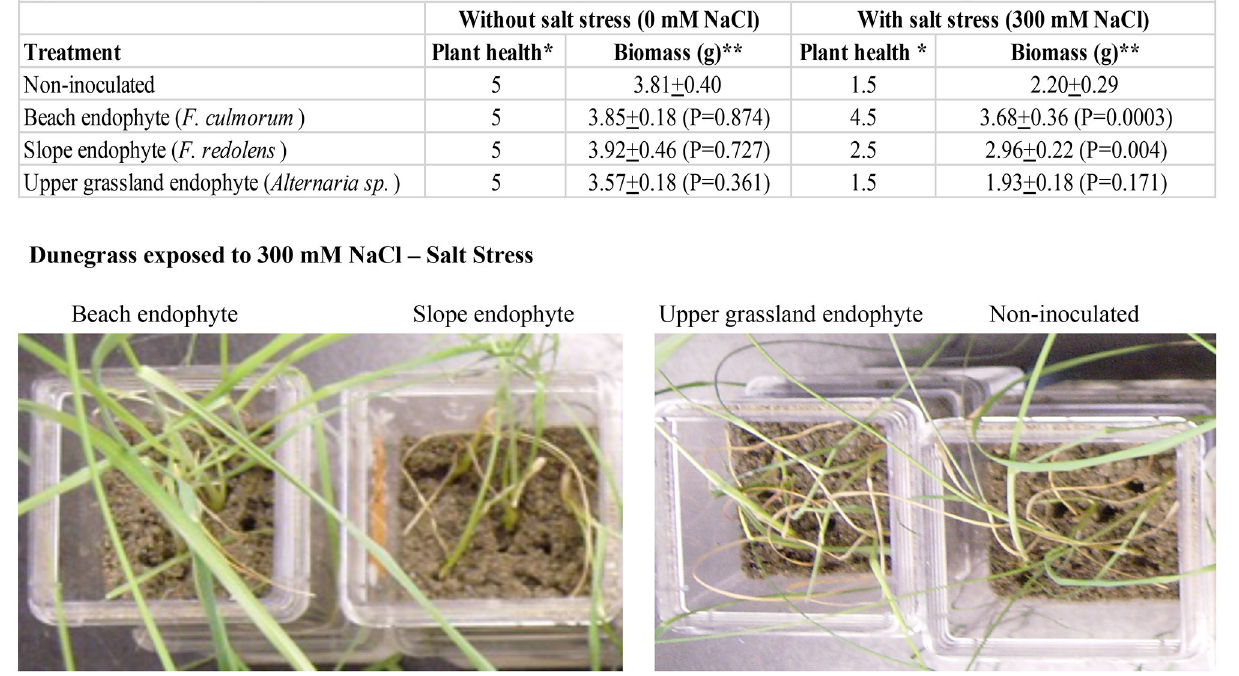
FIGURE 2 | Laboratory studies were conducted in double-decker magenta boxes with four-week-old dunegrass plants (5 plants /magenta box, x10 reps of each treatment). Treatments were uninoculated controls, or symbiotically colonized F. culmorum, F. redolens, or Alternaria sp. plants. The average plant health score (*) and wet biomass (**) of five magenta boxes/treatment exposed to 0mM or 300mM NaCl after 2 weeks ± standard deviation values were recorded (table on top). The plant health score was assessed on a scale of 1–5 (1 = dead, 2 = severely wilted and chlorotic, 3 = wilted + /- chlorosis, 4 = slightly wilted, and 5 = healthy w/o lesions or wilting). The highest salt tolerance was found with F. culmorum, and moderate and no salt tolerance were observed with F. redolens and Alternaria sp. plants, respectively, when compared to uninoculated controls. No differences in plant health or biomass were observed in treatments in the absence of salt stress. In the presence of 300mM NaCl stress, differences in plant health and biomass were observed in F. culmorum and F. redolens treatments, and no plant health or biomass differences were observed in Alternaria sp . treatments when compared to uninoculated controls. A representative photograph showing health differences in dunegrass treatments (lower panel) exposed to salt stress (300mM NaCl). Statistical analysis was performed using Student’s t -test. P < 0.05 values were determined to be